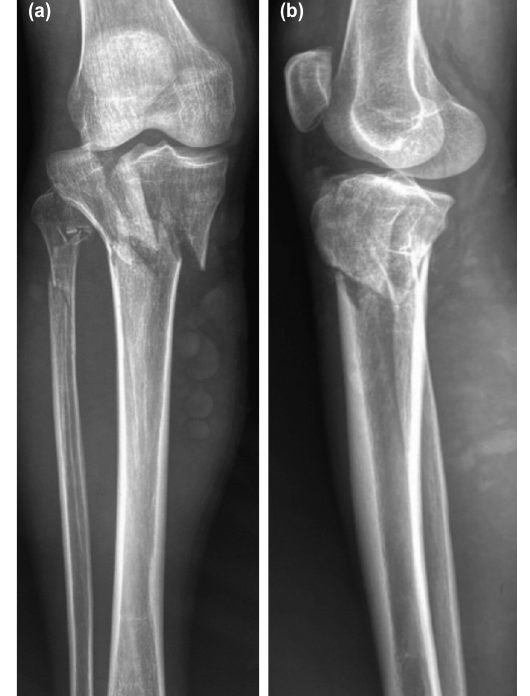
Case No.7, pre-operative radiographs of the knee Fig. 2: showing Shatzker Type VI fracture. (a) Antero-posterior view. (b) Lateral